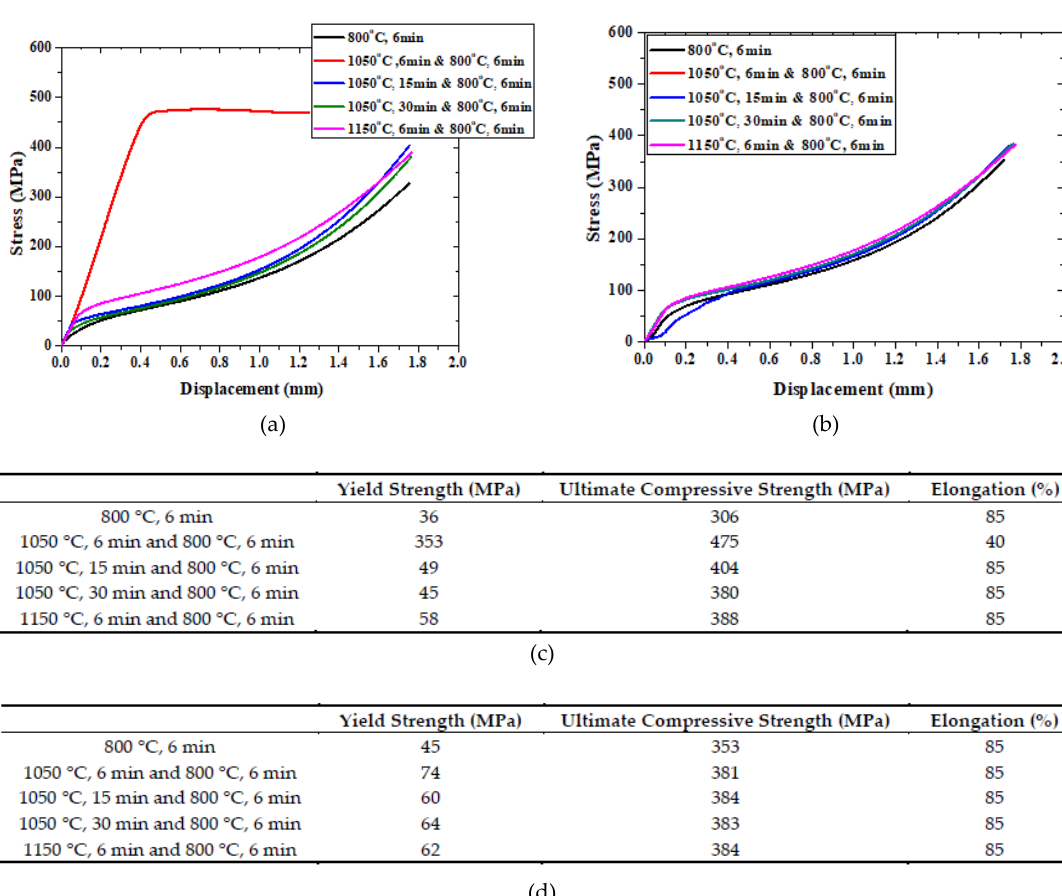
Figure 11. Compression test of the specimens heat-treated under different conditions along the ND: